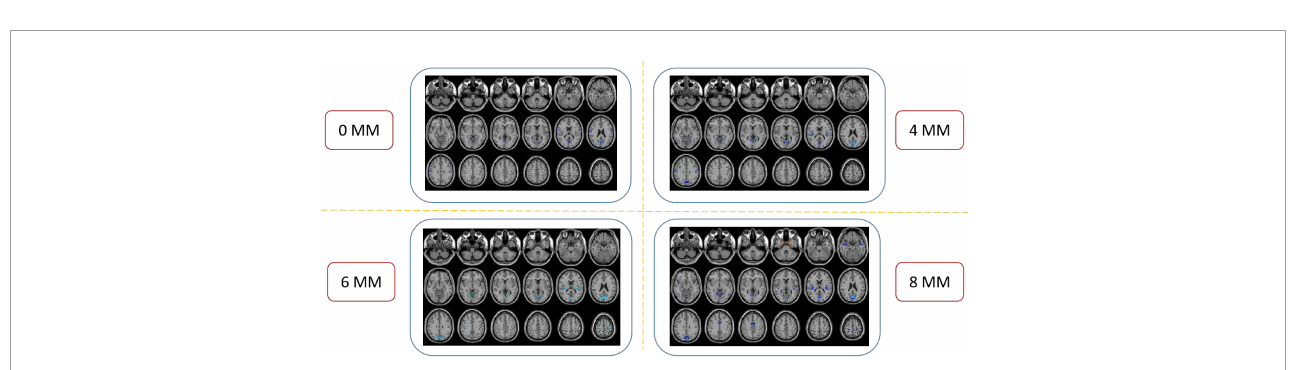
FIGURE2 Compared to healthy controls (HCs), the patients with primary angle-closure glaucoma (PACG) showed remarkably similar altered voxel-mirrored homotopic connectivity (VMHC) brain areas at different level of spatial smoothing. FWHM = 0, 4, 6, and 8 mm. ( P < 0.005, cluster > 26 voxels, AlphaSim corrected). The hot (cool) color indicates significantly increased (decreased) VMHC brain area. HCs, healthy controls; PACG, primary angle-closure glaucoma; VMHC, voxel mirrored homotopic